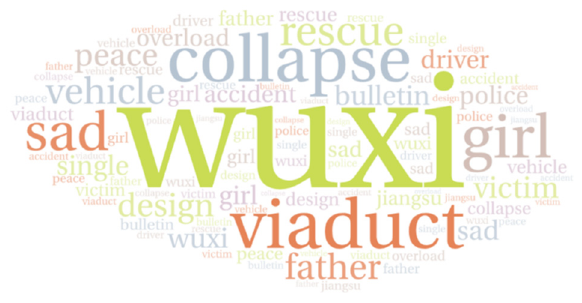
Figure 9. Word cloud for words related to the accident.